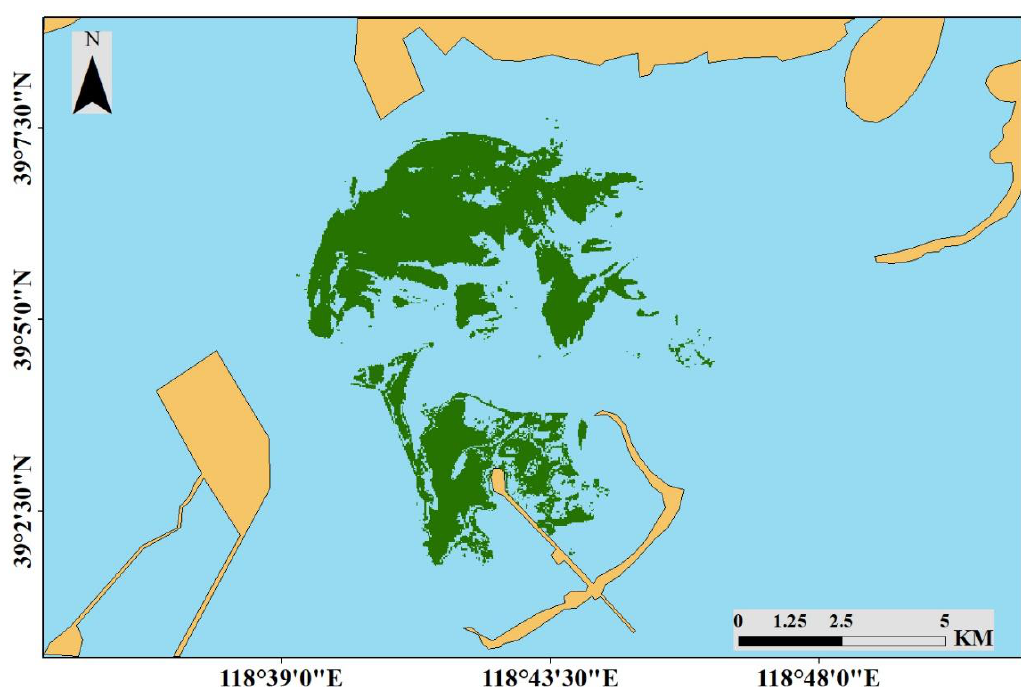
Figure 7. Seagrass distribution acquired from unsupervised classification (ISODATA) using Landsat 8OLI (29 June 2018) images.